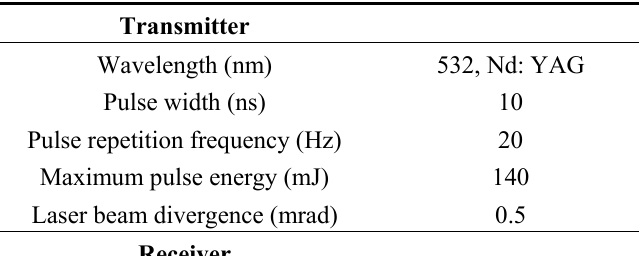
Table 1. Mie LIDAR